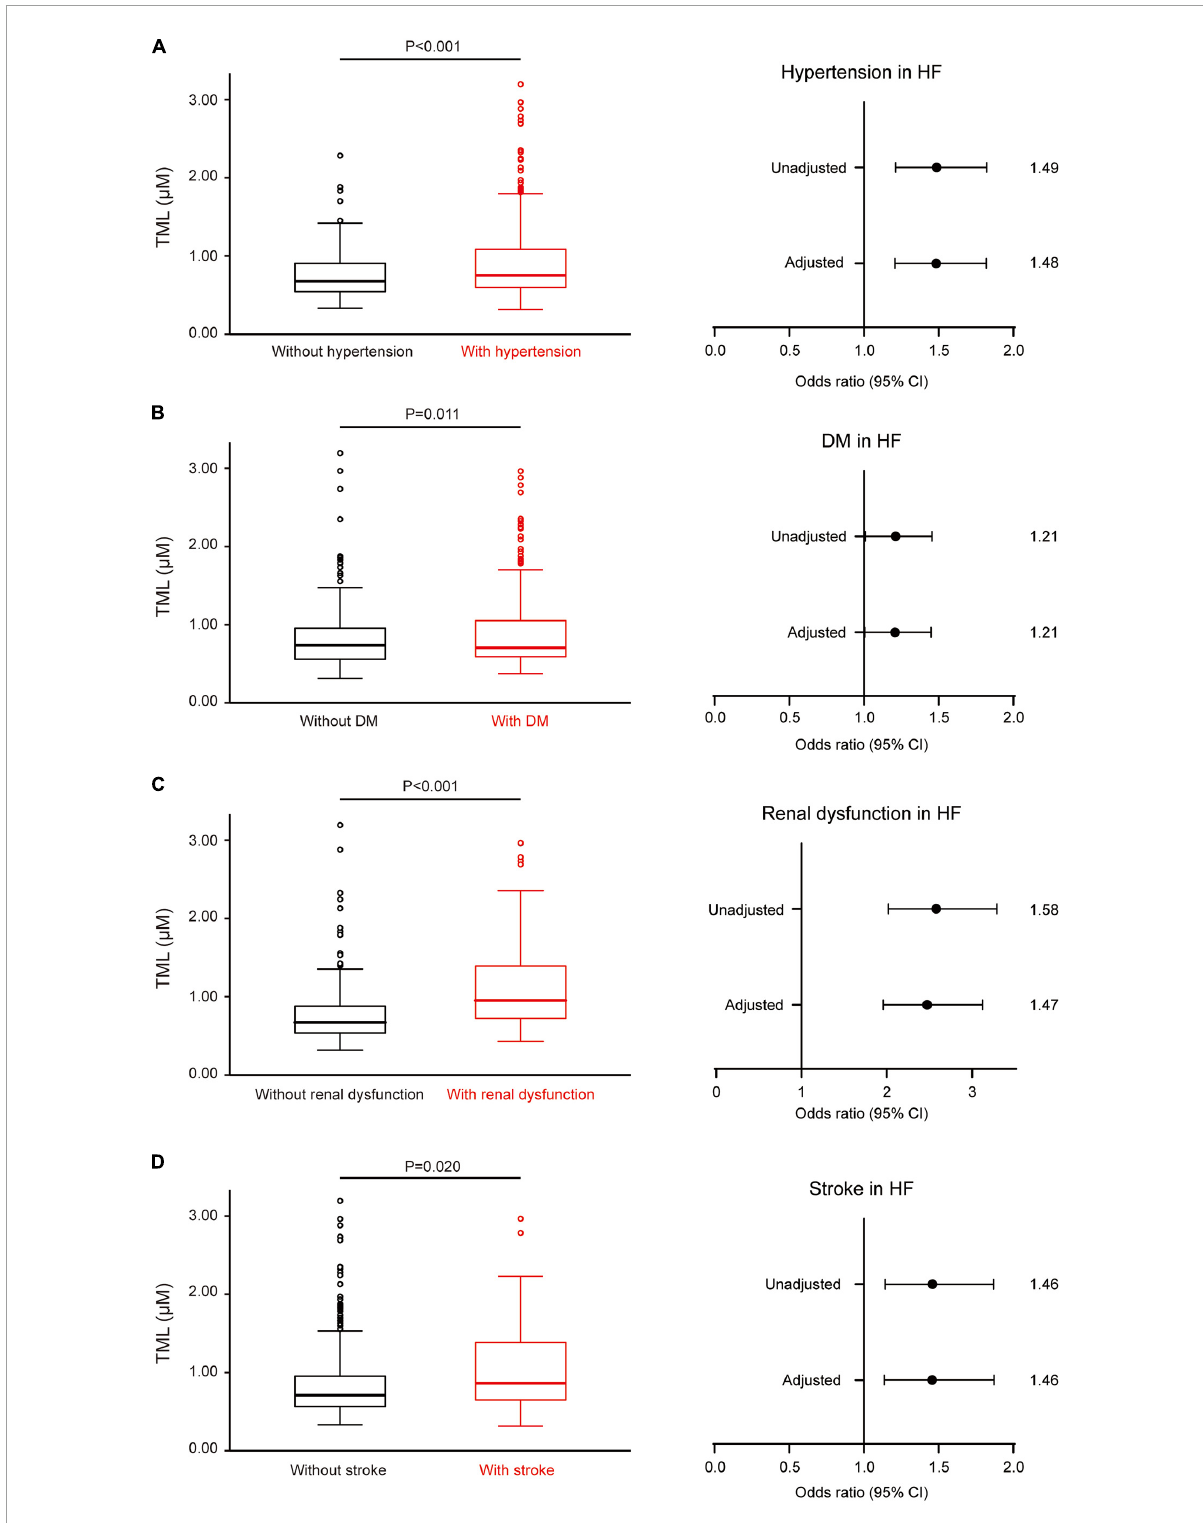
FIGURE2 Trimethyllysine (TML) levels are associated with several complications in patients with heart failure (HF). (A) In HF patients, serum levels of TML are elevated in those with hypertension than those without it. The forest plot at right illustrates the odds of the presence of hypertension according to TML levels in patients with HF, both unadjusted and adjusted for age, sex, and body mass index (BMI). Similar results were found regarding diabetes mellitus (DM) (B) , renal dysfunction (C) , and stroke (D)